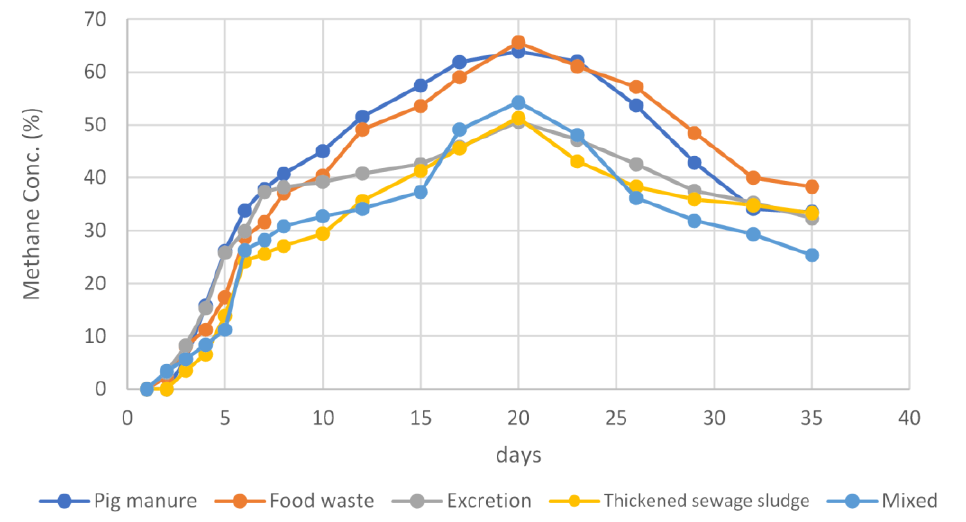
Figure 2. Biogas methane concentration (BMP test).